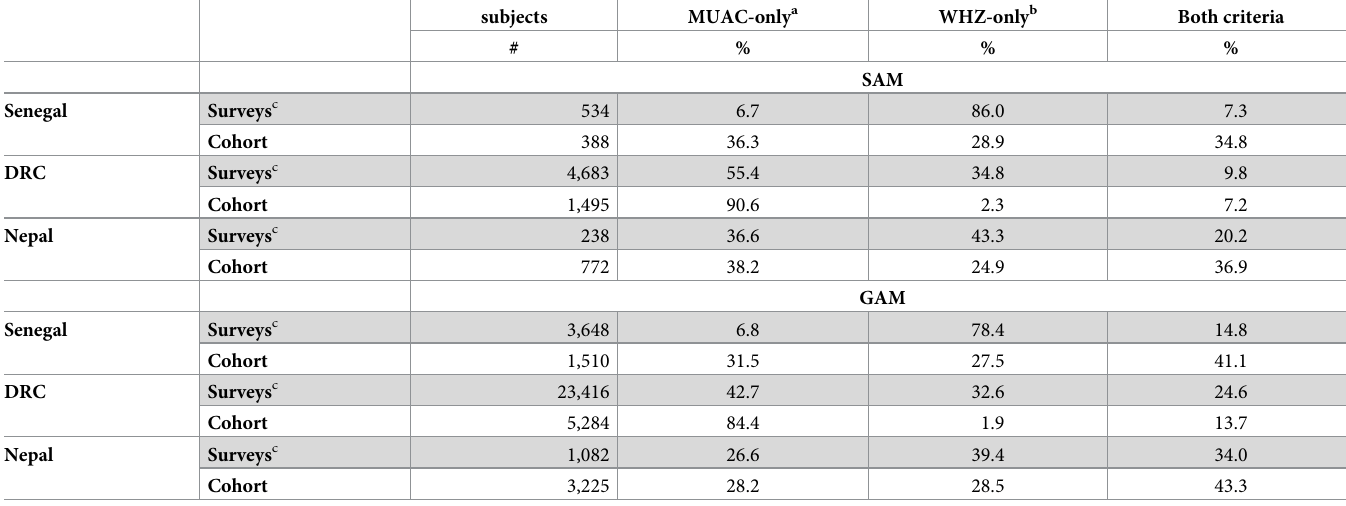
Table 4. Comparison of the proportions of children with Global Acute Malnutrition (GAM) and Severe Acute Malnutrition (SAM) obtained from modern ran- domly selected community surveys and from the historical cohorts analyzed in the present